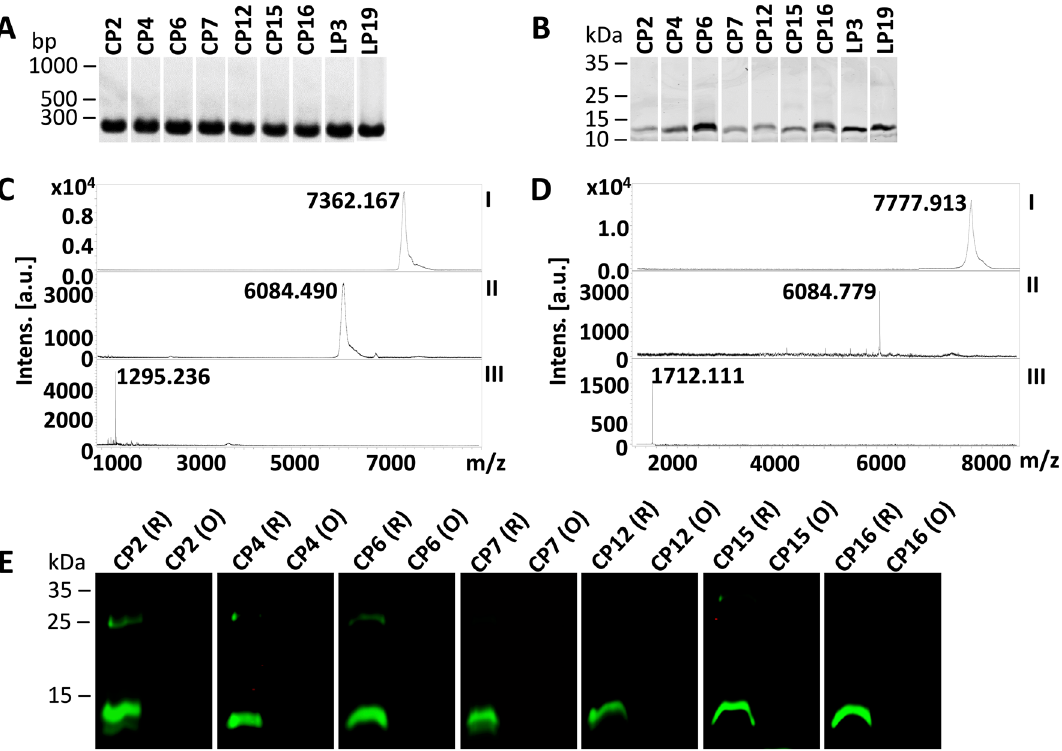
Figure 2. Production of DIII blocking peptides and assessment of the presence of disulfide bond. ( A ) Amplicons encoding tagged peptides resolved on the agarose gel; ( B ) Purified tagged peptides on LDS-PAGE. ( C ) Molecular mass of the representative cyclic peptide (CP2) confirmed by MALDI-TOF MS; ( D ) Molecular mass of the representative linear peptide (LP3) confirmed by MALDI-TOF MS. Predicted masses of tagged peptides (~ 7 kDa) corresponded to observed masses in MALDI-TOF MS ( C and D ), however, tagged peptides had slower migration in LDS-PAGE (B). In ( C and D ): I – tagged peptide; II – the tag (6xHis tag – 28 aa tag – GGGGS linker) after enterokinase digestion; III – purified peptide after removal of the tag. ( E ) The presence of disulfide bonds in cyclic peptides was confirmed. Any free thiols present in the peptides were blocked with N -ethylmaleimid (NEM). Peptides were then either reduced (R) or maintained in oxidized form (O). Both R and O forms were incubated with thiol-reactive IRDye 800CW Maleimide and then separated on non-reducing LDS-PAGE. In the peptide, if thiols are occupied with the disulfide bond, they remain unblocked and get reduced with TCEP. Free thiols in reduced peptides are then labeled giving a green signal. In the oxidized form, no free thiols are available, thus no labeling occurs (no green